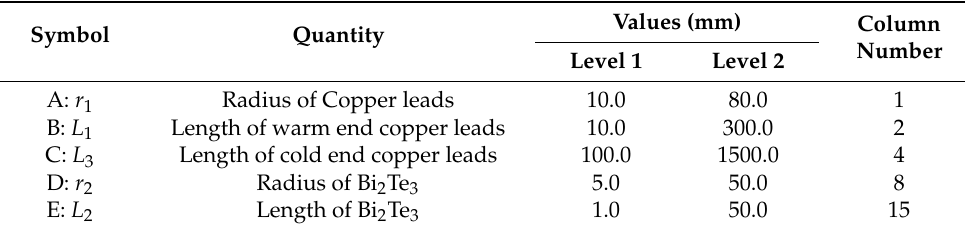
Table 4. Orthogonal experimental design for 1200 A